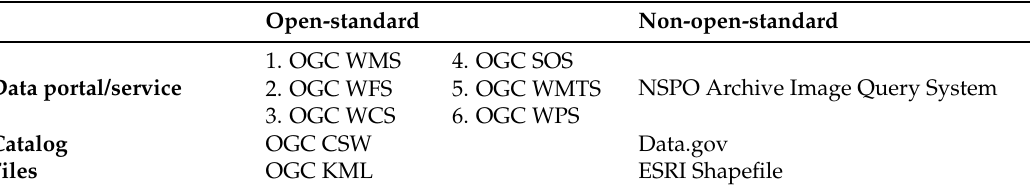
Table 2. GeoWeb resource searching